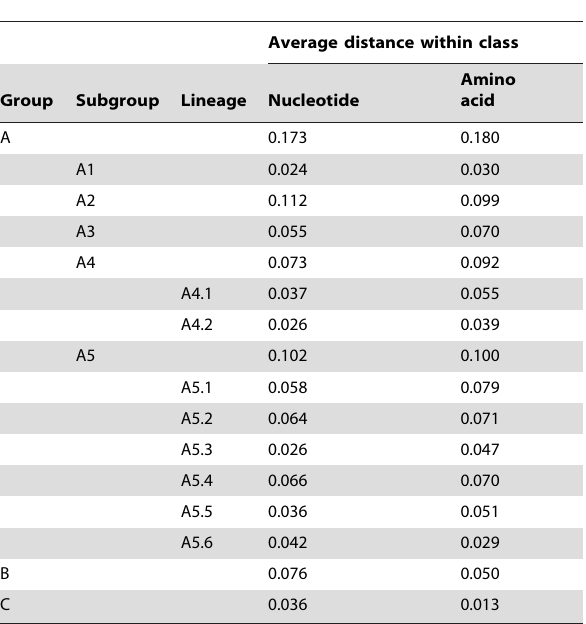
Table 1. Distance estimation within classes for the novel NS1 classification using nucleotide and protein